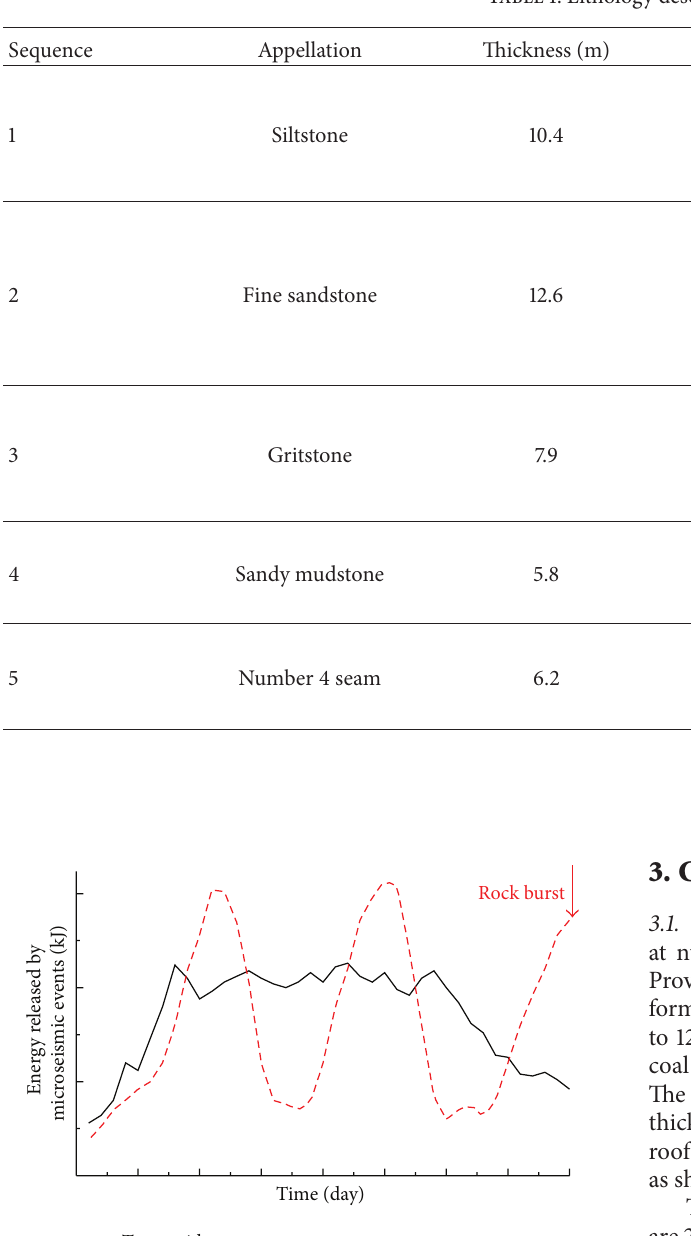
Table 1: Lithology description.